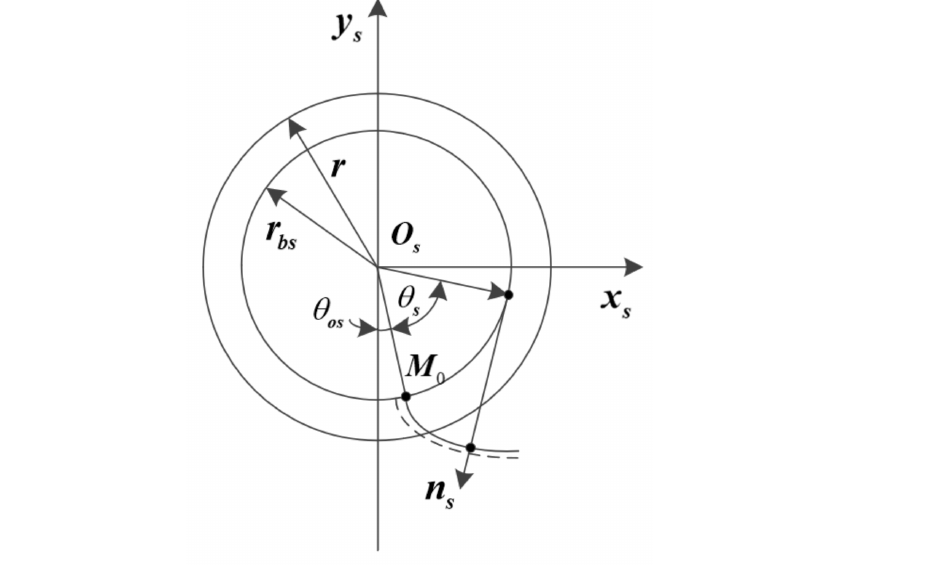
Figure 2. Shaper involute tooth profile.